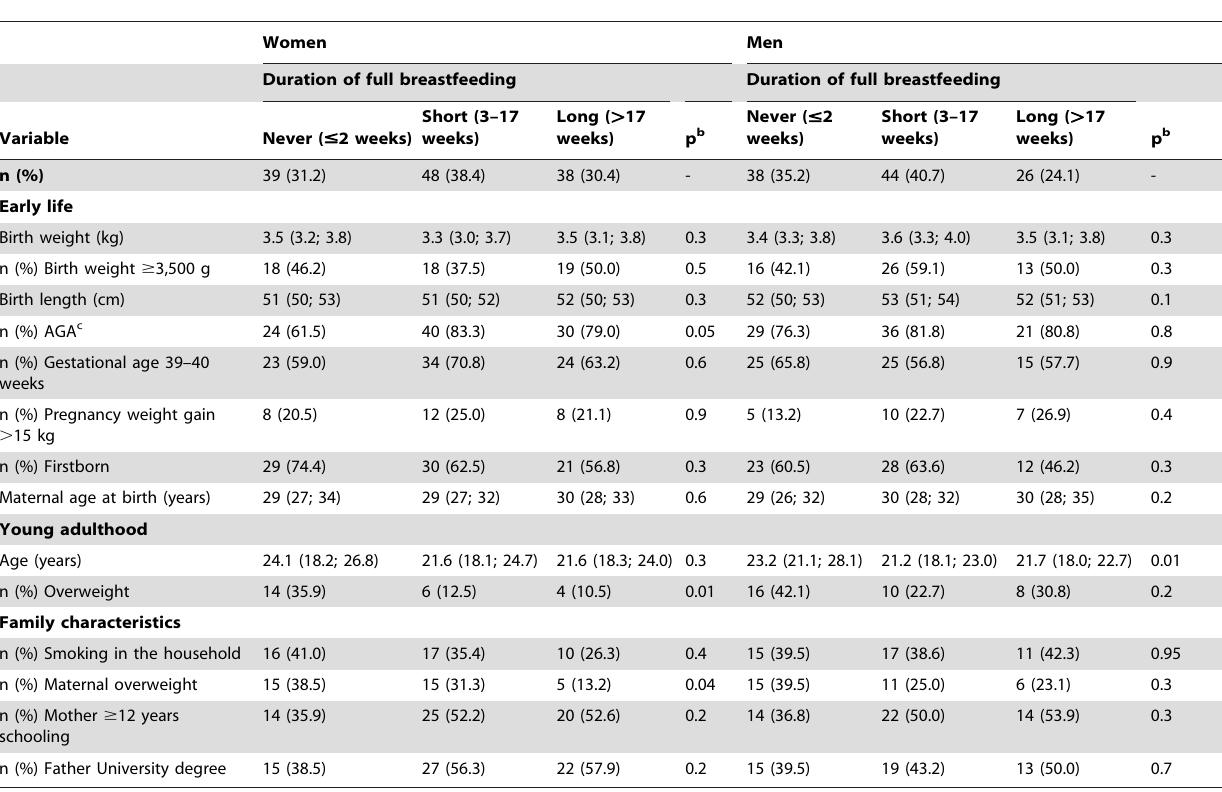
Table 1. Characteristics of the study sample according to duration of full breastfeeding in infancy, DONALD Study (n= 125 women, 108 men) a